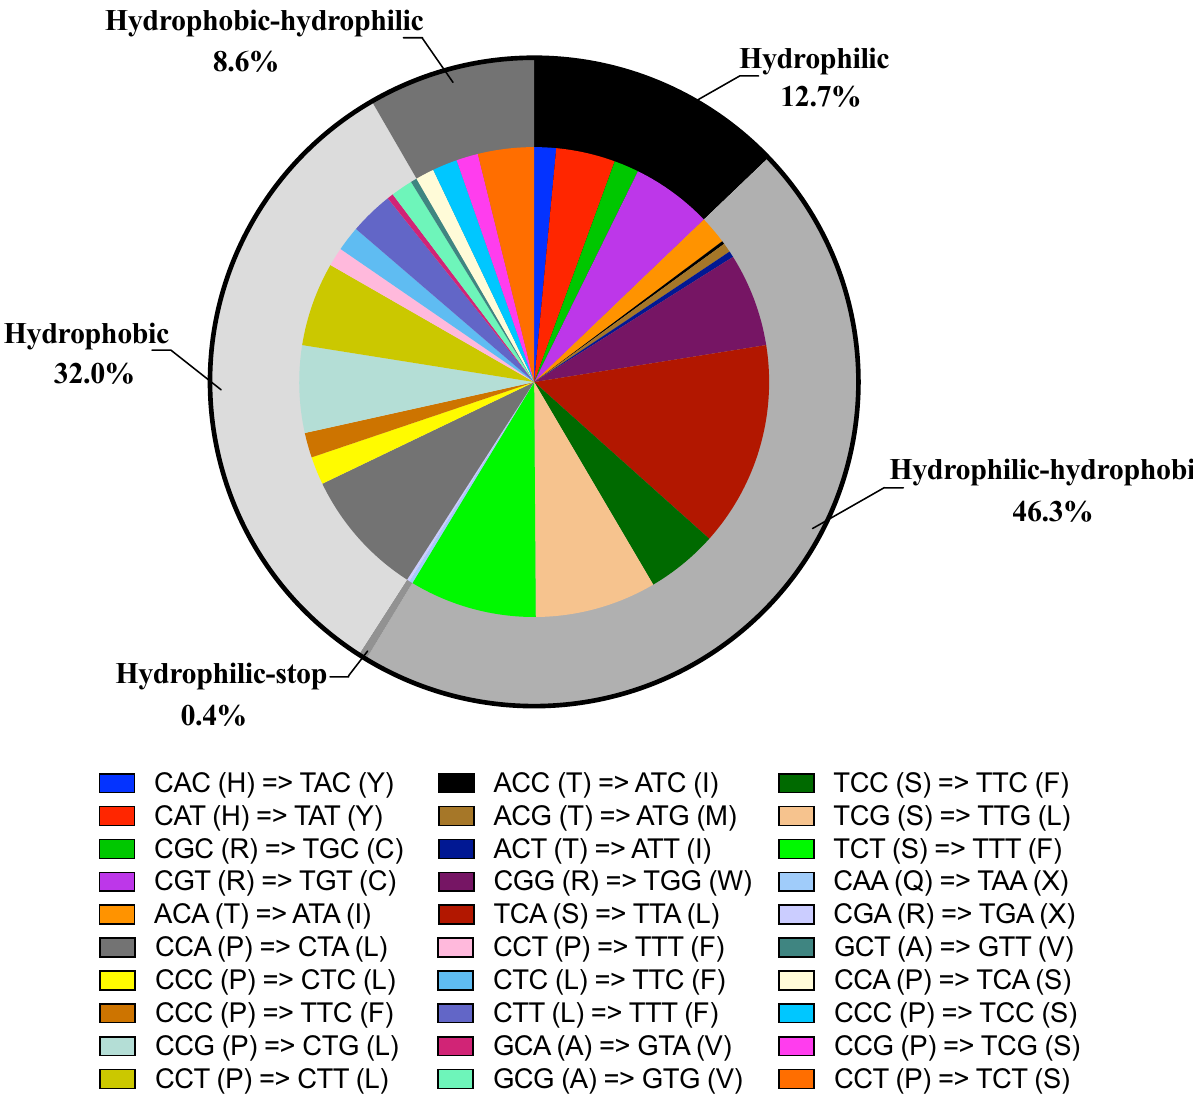
Figure 6. Prediction of RNA editing sites in the P. serratifolia